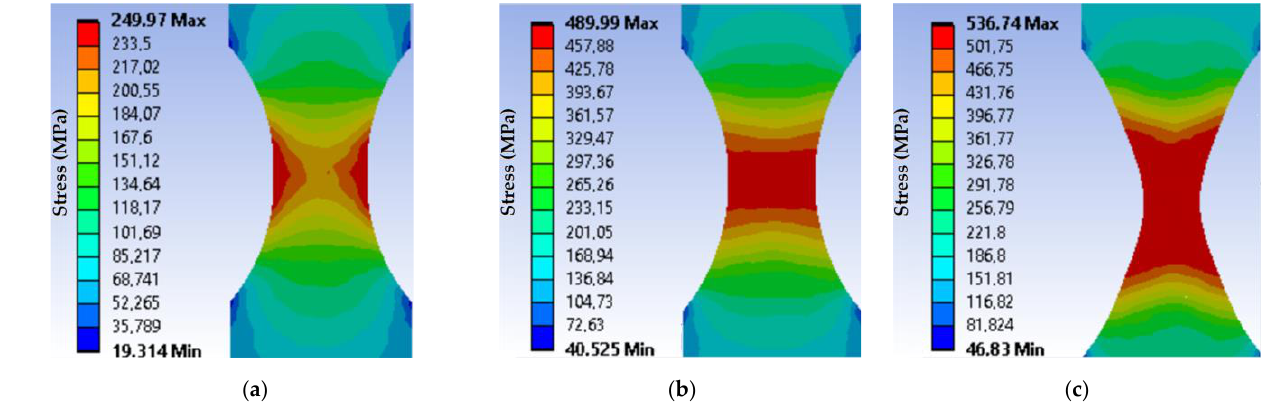
Figure 7. Equivalent stresses distribution in the sample during its loading under the load mode І : ( а ) when the equivalent stresses reach the yield strength; ( b ) when the equivalent stresses reach the ultimate strength; ( с ) at the fracture moment.